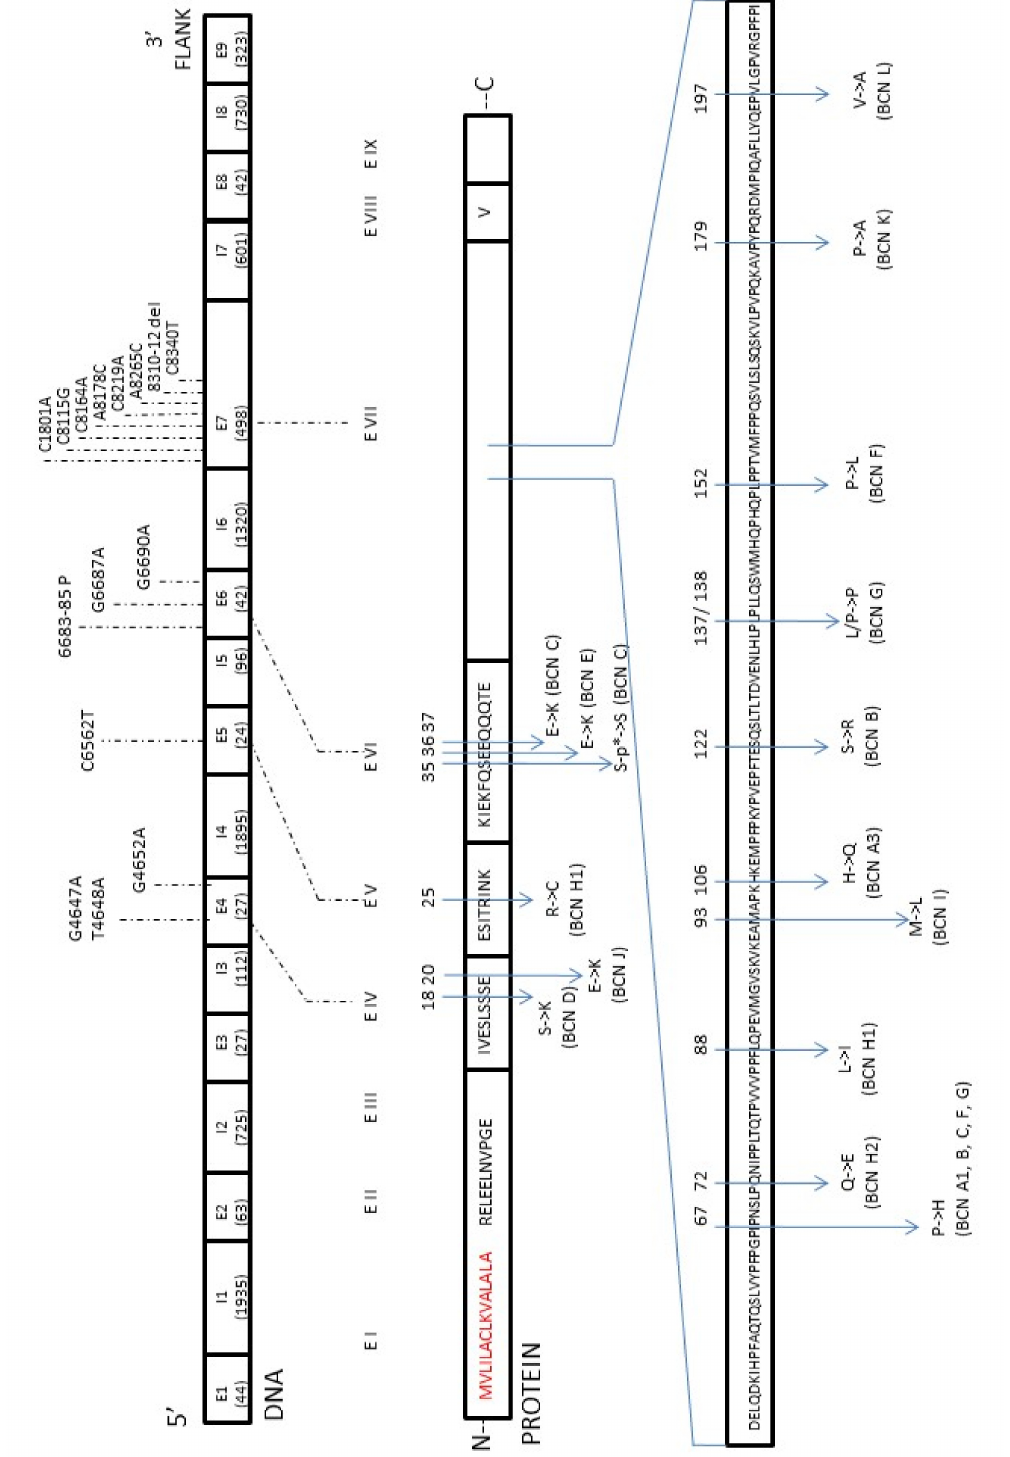
Figure 1. The map of mutations found in the β -casein (CSN2) gene in relation to the amino acid changes with the β -casein protein ( β